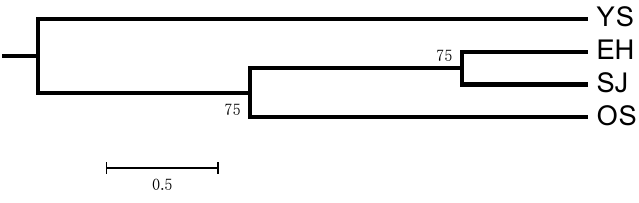
Figure 3. The unweighted pair-group method analysis (UPGMA) tree based on the ( δμ ) 2 genetic distance of four Pacific cod populations. Results of bootstrapping (1000 replicates) are shown at nodes.